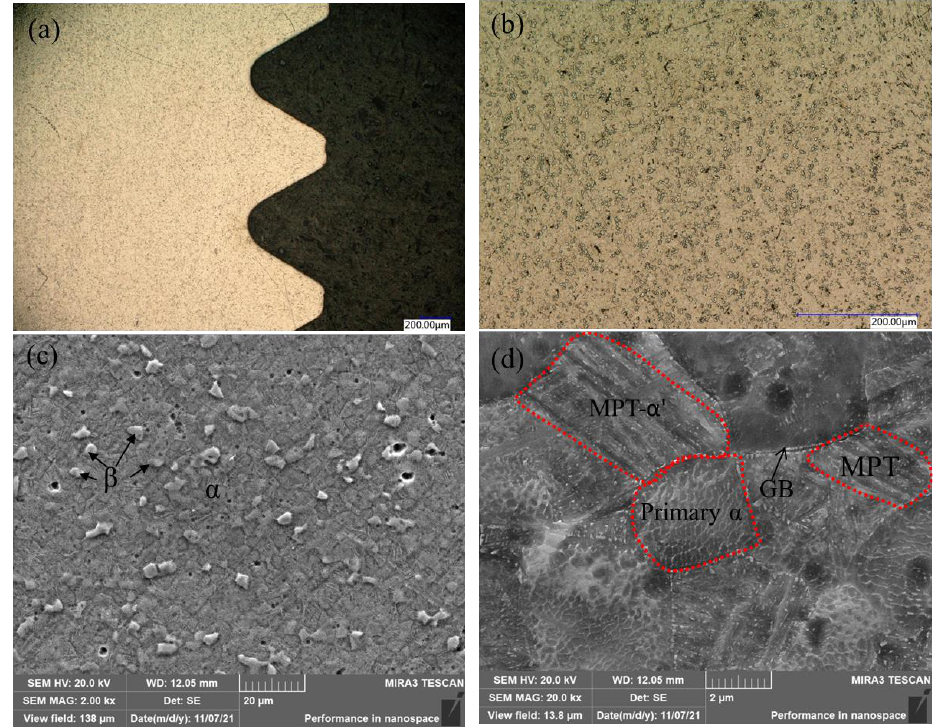
Figure 2. Microstructure of the bolt: ( a , b ) optical microscopy; ( c , d )